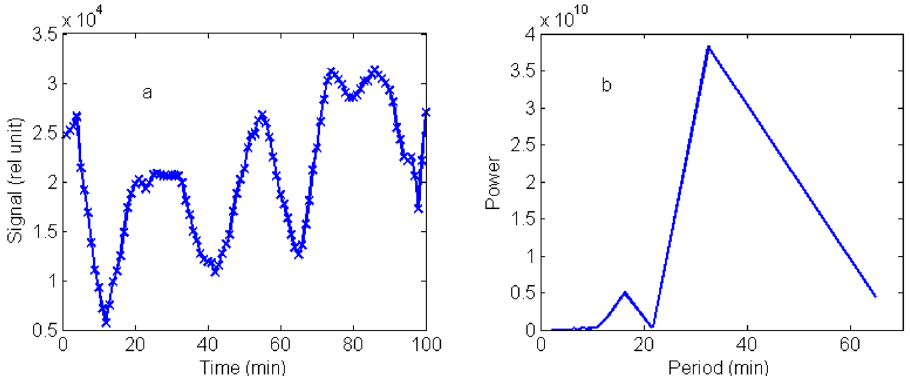
Figure 5. ( a , left) Time series of integrated signals in 3–8 km heights ( b , right) FFT power of signal of Fig. (5a) with the major peak at 32.5 min and a minor peak at 16.2 min.